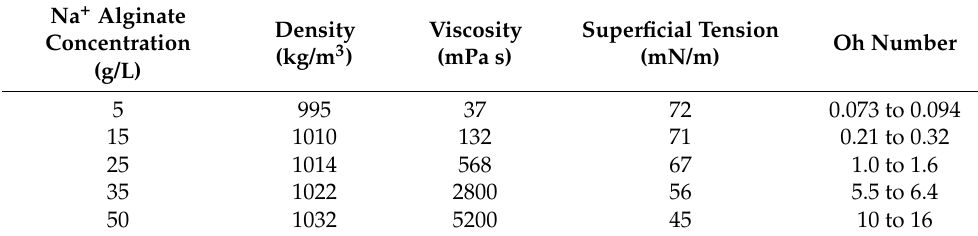
Table 1. Physical properties of different sodium alginate